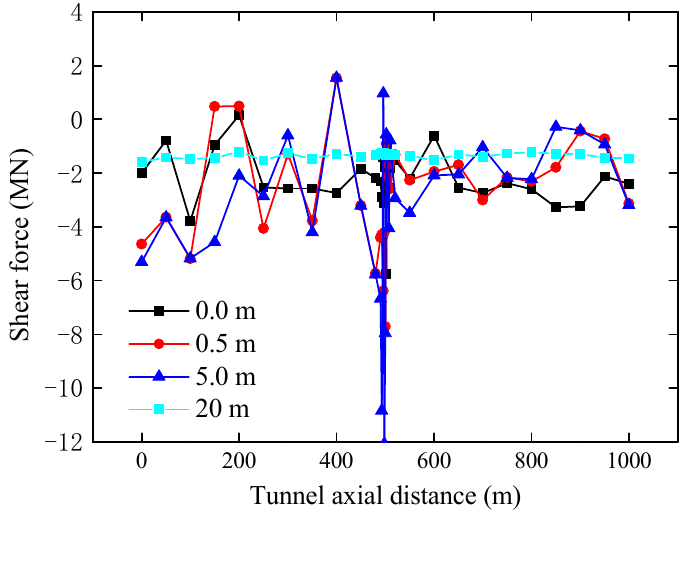
Figure 13. Shear force of the lining monitoring points of the tunnel passing through adverse geological structure zone with different thicknesses along the tunnel axial direction.